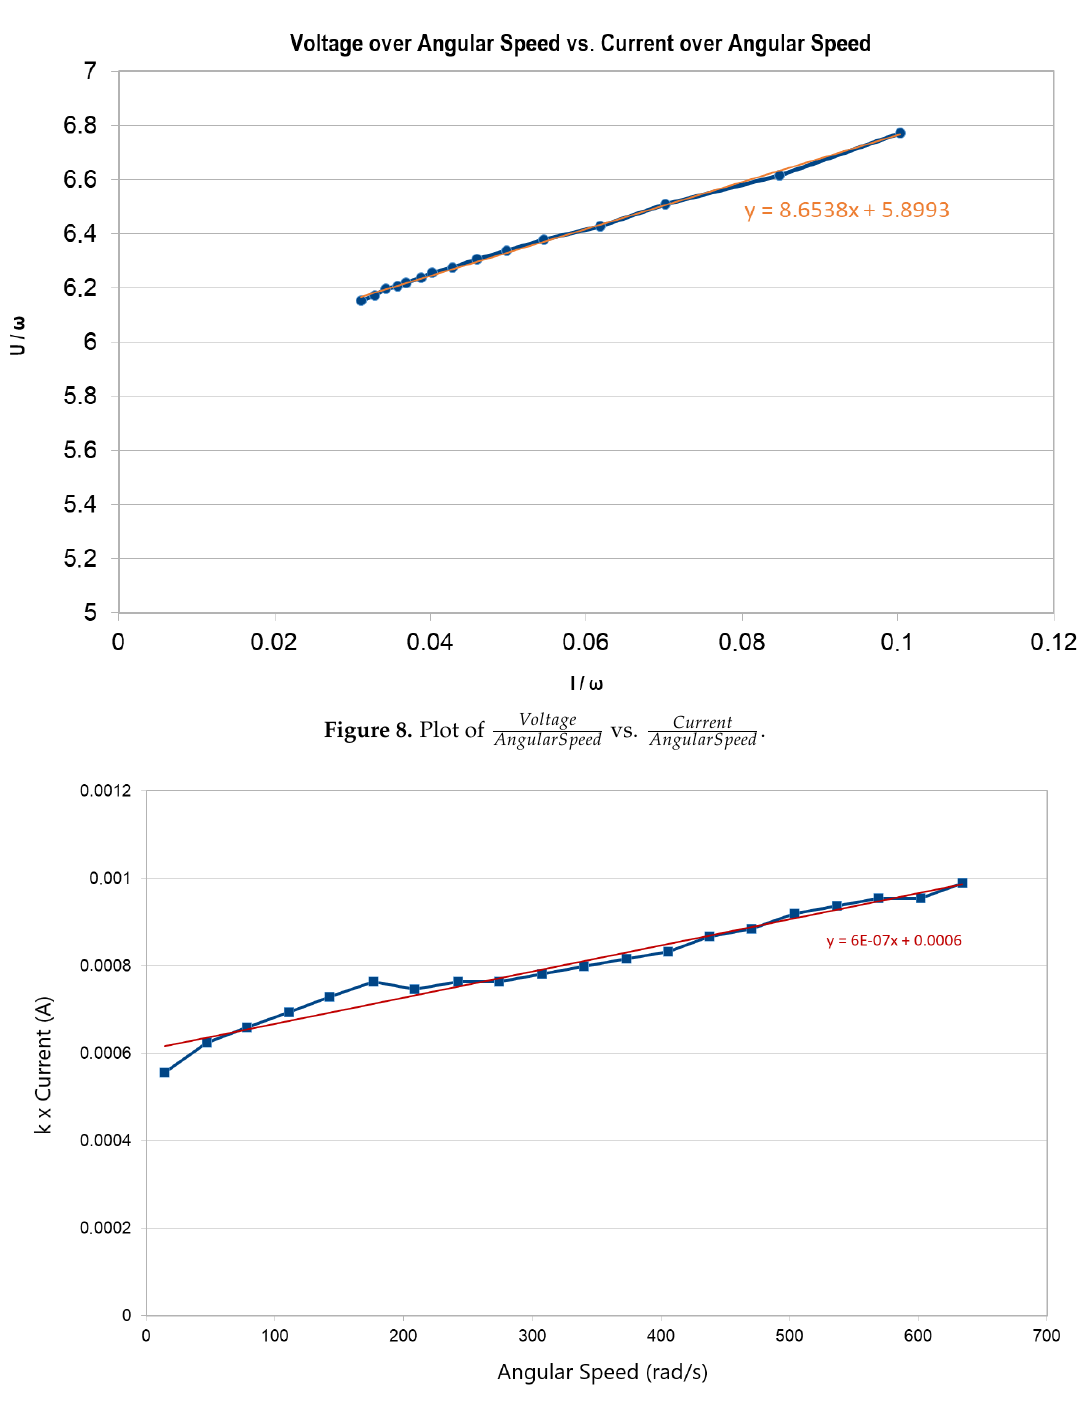
Figure 9. Plot of k · Current vs. Angular Speed ω